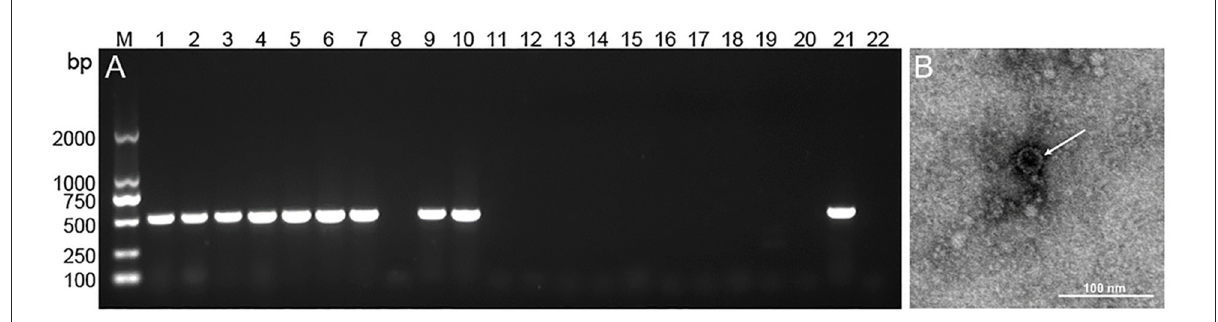
FIGURE6 Representative figure showing the confirmation of CEV/OEV infection in specimens by RT-PCR and electron microscopy. (A) PCR amplification of the representative ELISA-detected positive (lane 1–10) and negative (line 11–20) specimens with a positive (lane 21) and negative control (line 22). (B) Observation of enterovirus particle in ELISA-detected positive specimens by electron microscopy.